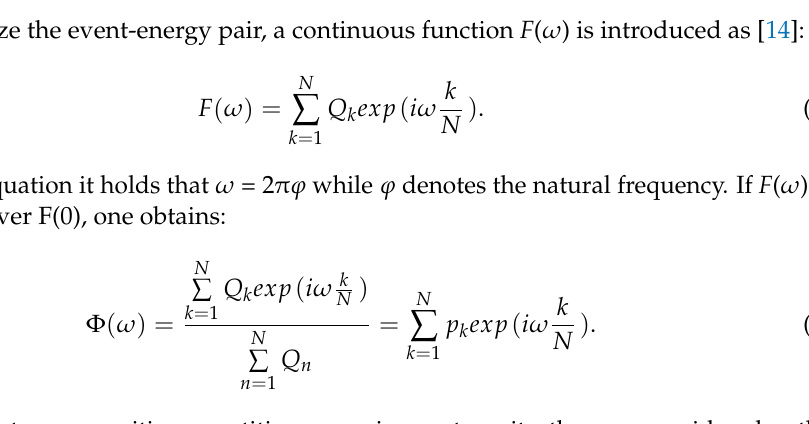
Figure 2. Interpretation of a time series in conventional- ( up ) and natural time domain ( down